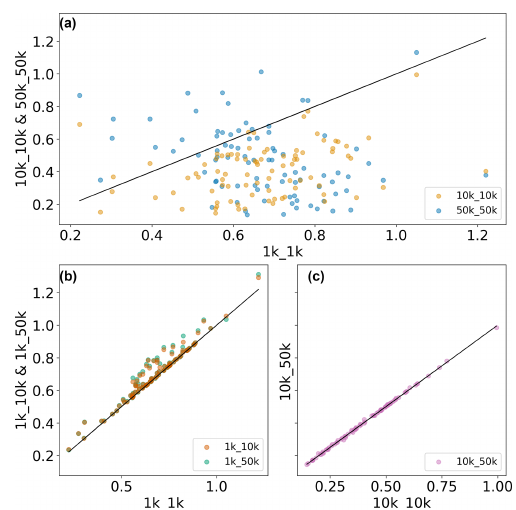
Figure B3. Scatterplot of RRMSE values obtained in the evaluation of simulated total evaporation with GLEAM data for (a) comparing different model resolutions, (b) comparing different forcing resolu- tions for 1K runs, and (c) comparing different forcing resolutions for 10K runs.